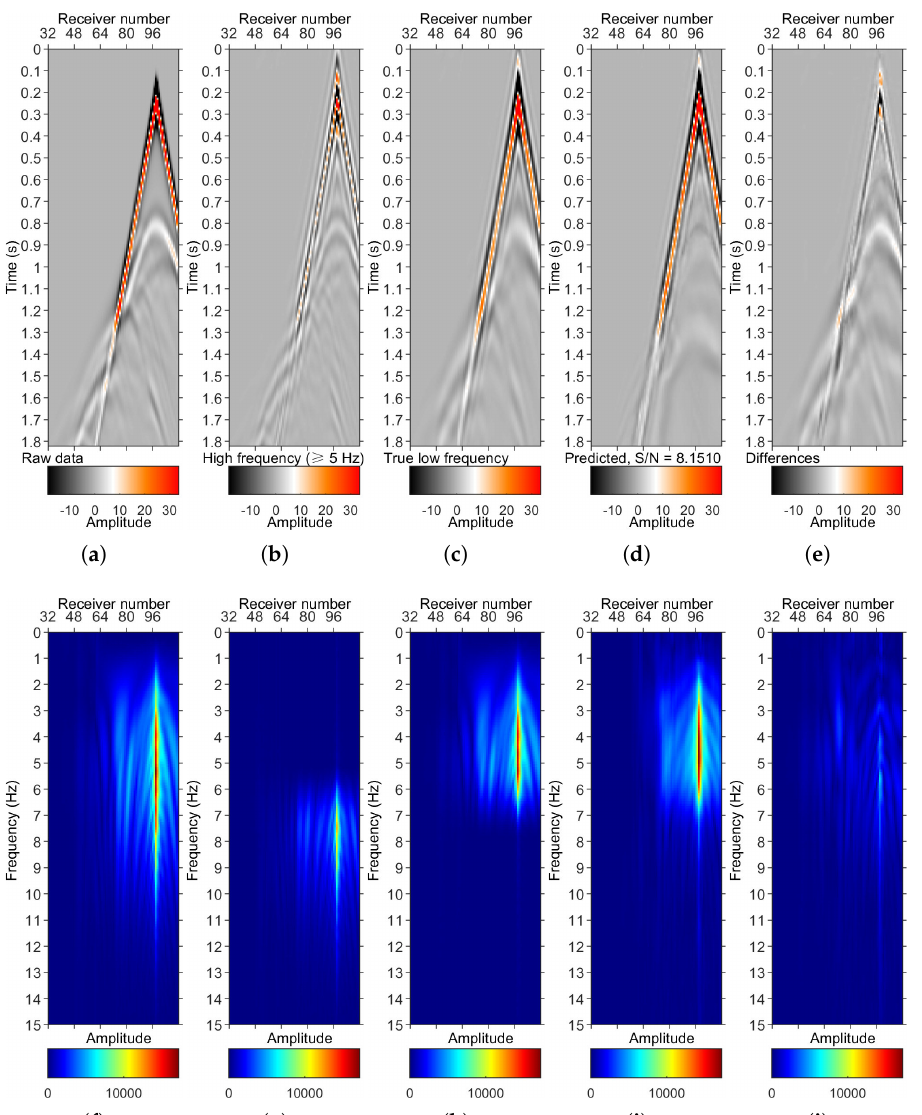
Figure 17. Test of the trained CNN on the completely unseen BP 2004 benchmark model [42]. ( a ) A shot gather simulated with the BP 2004 benchmark model. ( b ) High-frequencies ( (cid:62) 5 Hz) of ( a ). ( c ) Low-frequencies of ( a ). ( d ) Predicted low-frequencies by the proposed method. ( e ) Differences between ( c , d ). Panels ( f – j ) correspondingly show amplitude spectra of the Fourier transformed data (along the time direction) of the data shown in panels ( a – e